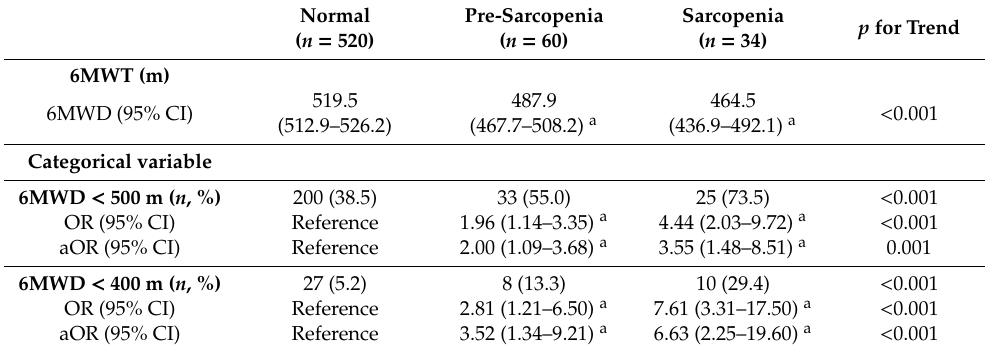
Table 2. Di ff erences in preoperative cardiopulmonary function by sarcopenia